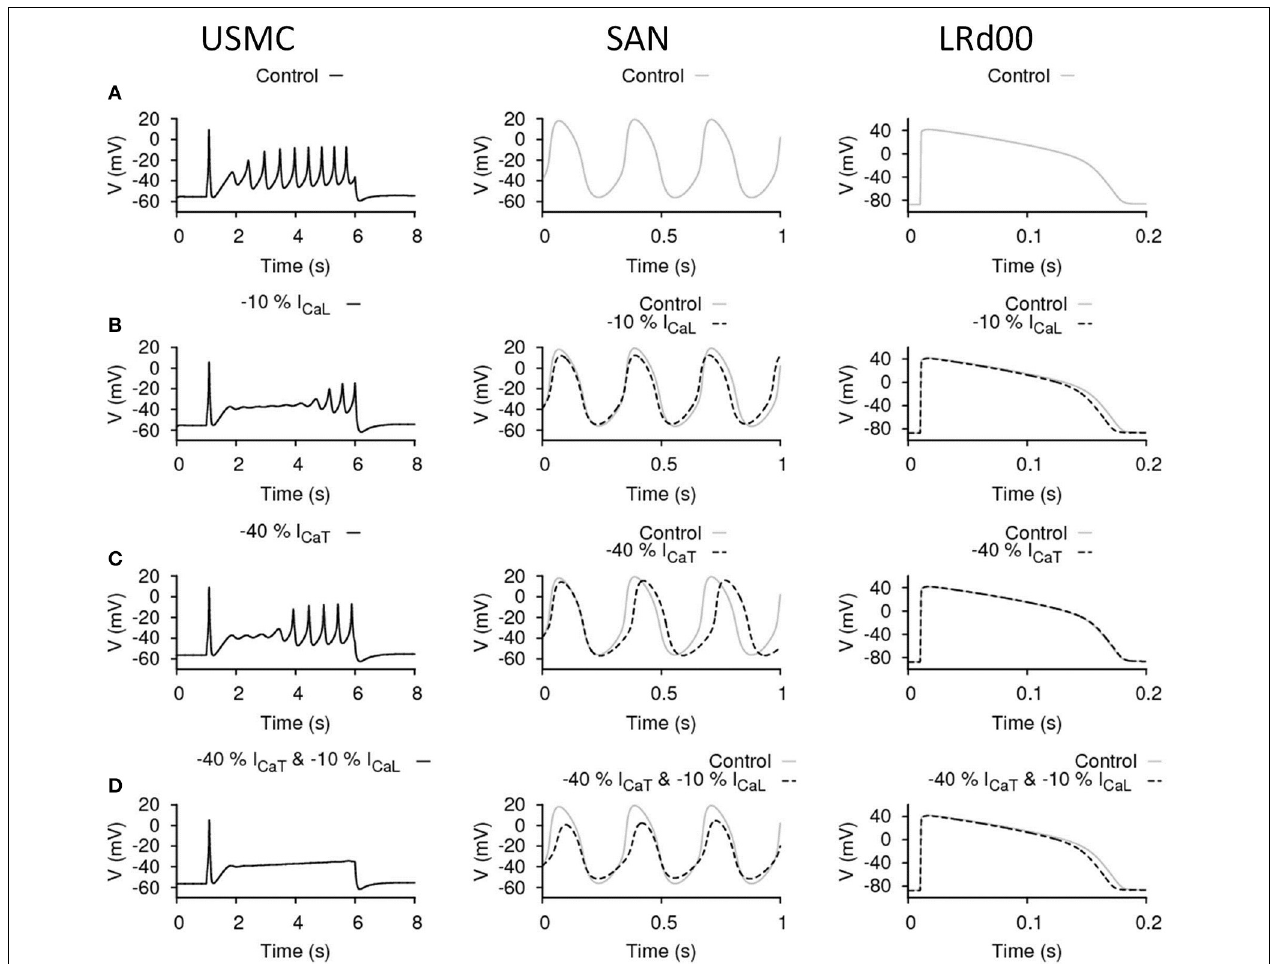
FIGURE 5 | Effects of reducing I CaL and I CaT in uterine and cardiac cells. Effects on the action potential forms and characteristics when both I CaL and I CaT were proportionally reduced in different cell types: the USMC cell model (left), the SAN cell model (center), and the LRd00 ventricular